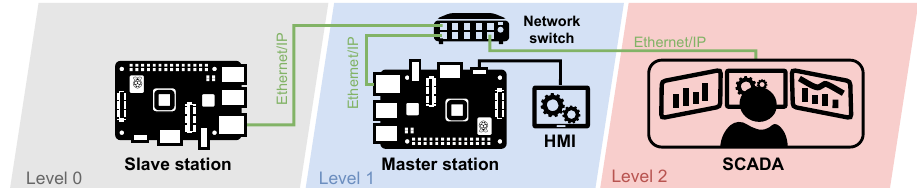
Figure 12. Diagram of the simulated wastewater treatment